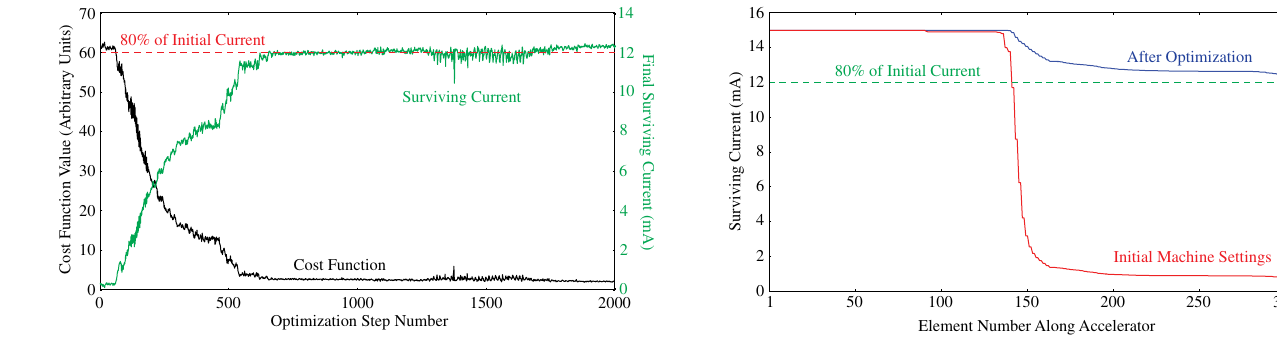
FIG. 8. The surviving current at the end of the beam transport over 2000 iteration steps is shown for an initial beam current of 15 mA.